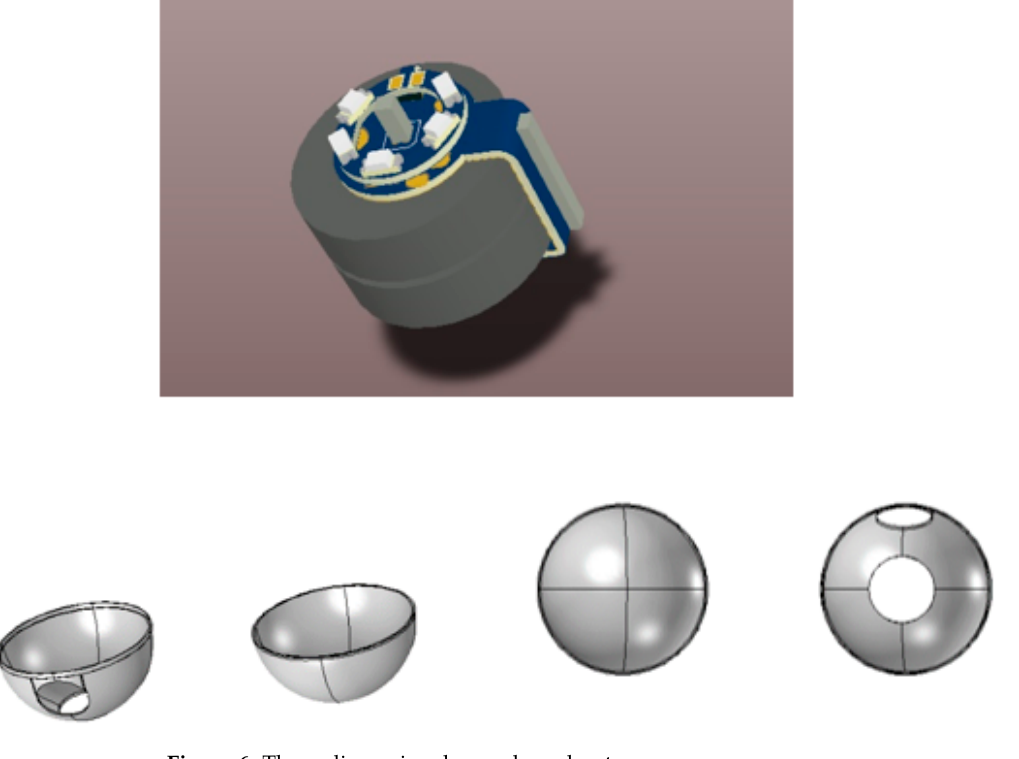
Figure 6. Three-dimensional capsule and outer cover.